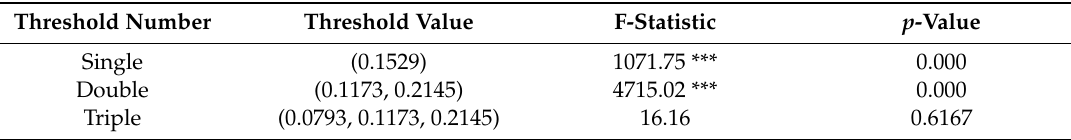
Table 7. Estimation and test of threshold value of technological upgrading